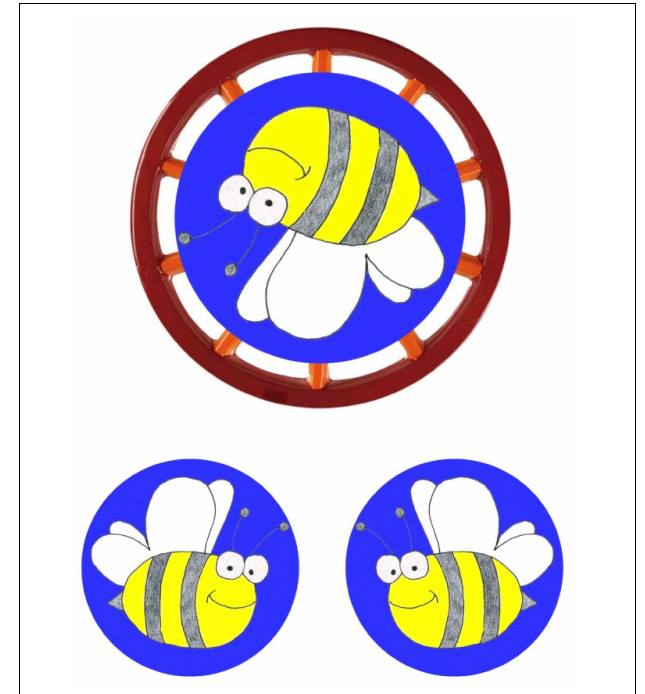
FIGURE 1 | Example of the stimulus configuration as presented on the screen (here: bee at 195 ◦ ).